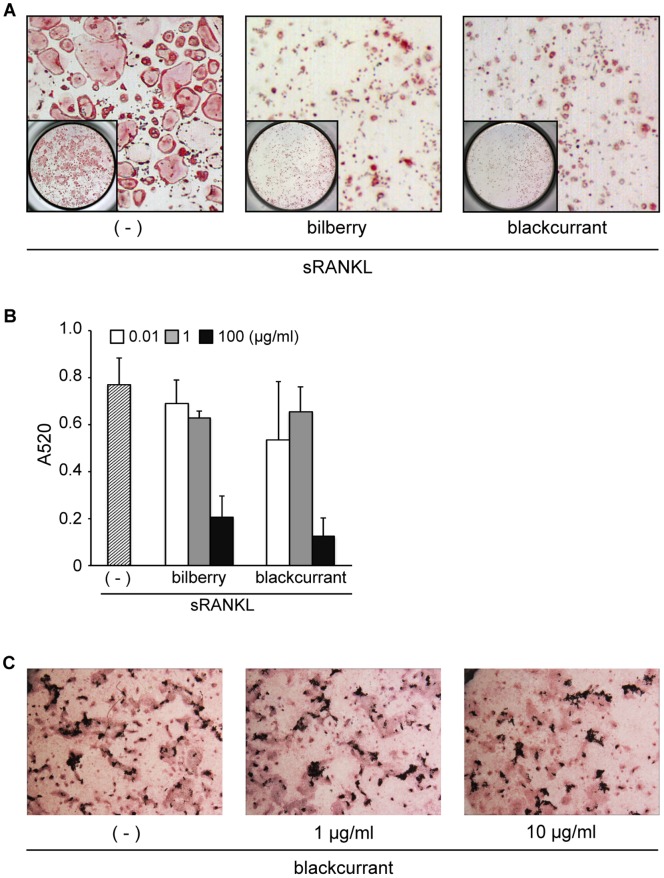
Anthocyanin-rich compounds extracted from bilberry and blackcurrants inhibit in vitro osteoclastogenesis, but not osteogenesis.RAW264.7 cells were pre-incubated for 1 h in the presence of various concentrations of anthocyanin compounds, and subsequently cultured for 4 days in the presence of 100 ng/ml RANKL. Cells were fixed and stained with TRAP. A: Numerous TRAP-positive multinucleated giant cells, osteoclasts, were induced by RANKL treatment (left panel). In contrast, large osteoclasts were significantly decreased by addition of anthocyanin compounds (middle and right panels). B: Anti-osteoclastogenic activity of anthocyanin compound was evaluated by the absorption ratio of the red-stained area per well at 520 nm on a spectrometer. C: Primary osteoblastic cells were cultured in the medium containing 50 µg AA, 10 µM Dex and 10 mM β-GP with or without anthocyanin compound for 2 weeks. No significant effect was observed on the osteoblast differentiation and mineral apposition.